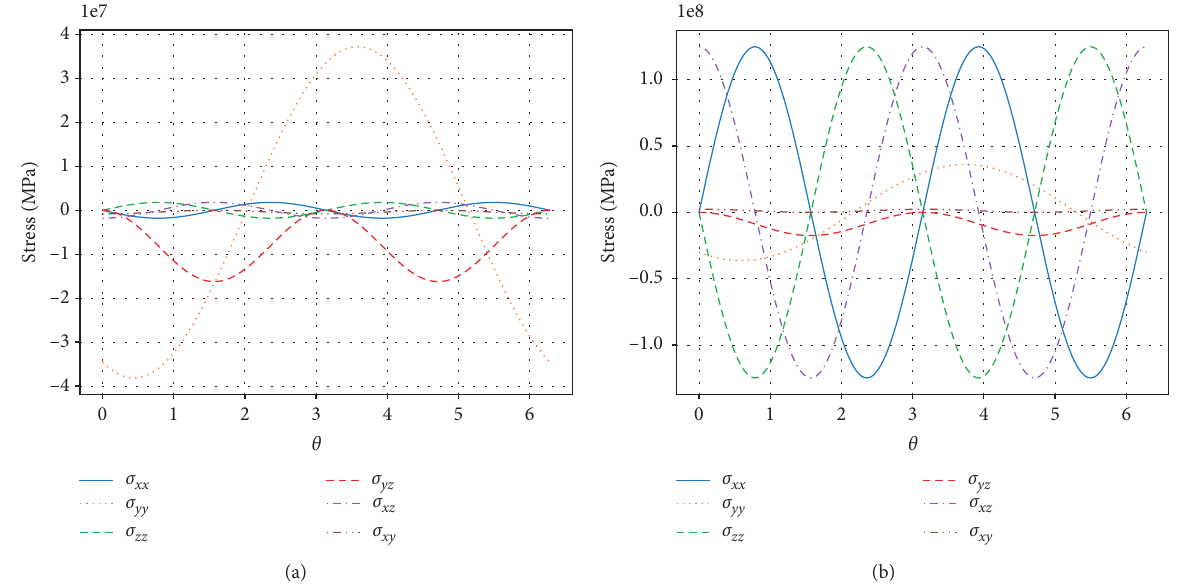
Figure 4: The stress associated with different position angle θ . (a) At time � 2 s and (b) at time � 20s.